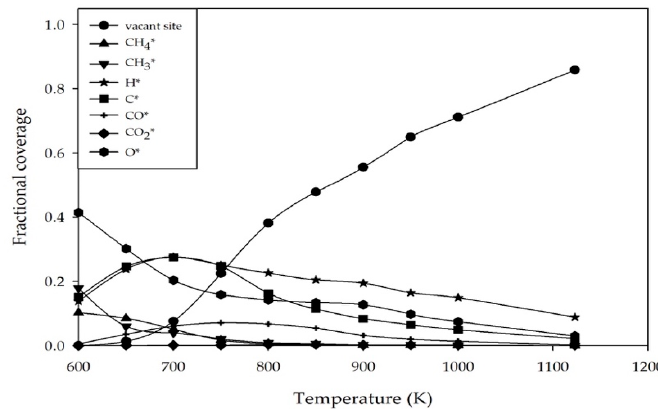
= = 0.4. Figure 6. Fractional coverages as a function of te reaction temperature; P = 1 bar and y CH 4 (cid:3120)